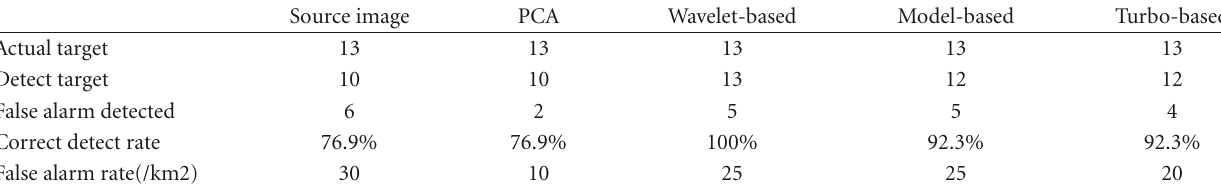
Table 3: CFAR evaluation result on the source and fusion result